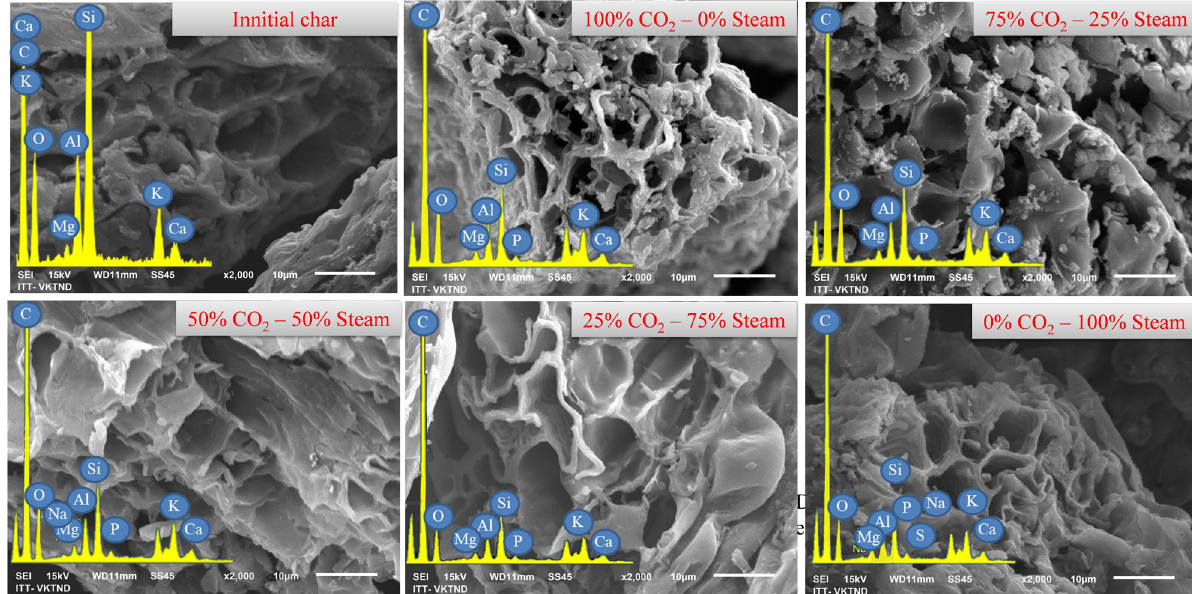
Figure 3. SEM images and EDX spectra of the original and activated chars.